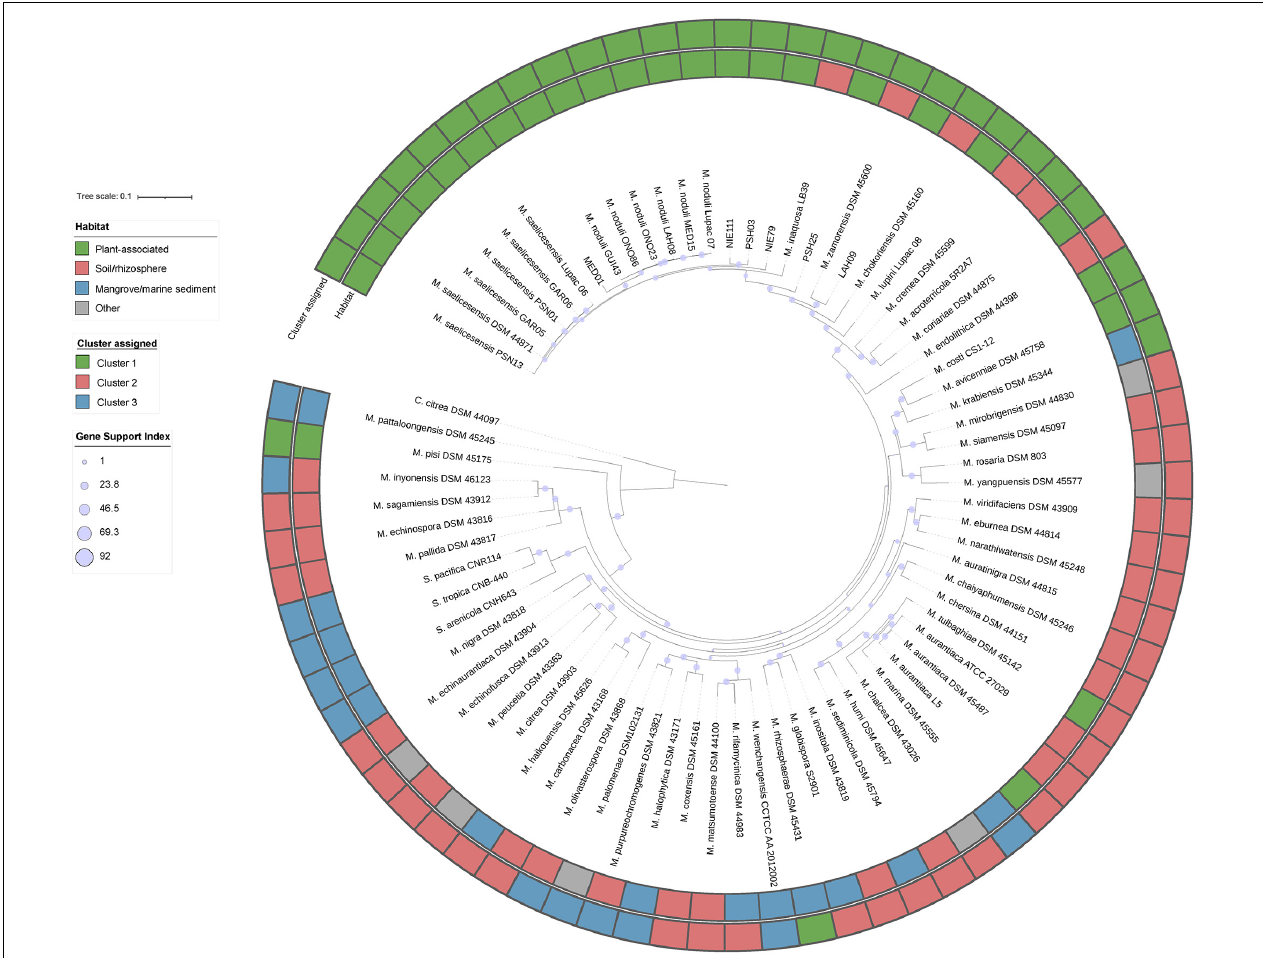
FIGURE 3 | Up-to-date bacterial core gene phylogenomic tree reconstructed with 92 bacterial core genes. Gene support indices are given at nodes as filled purple